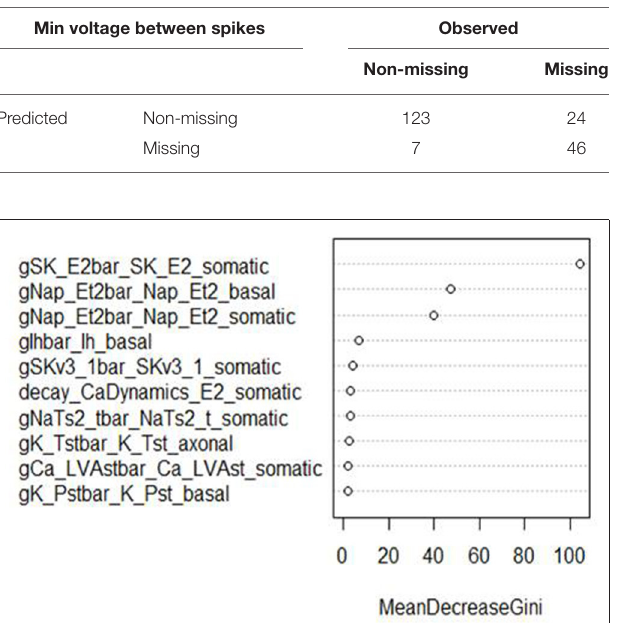
TABLE 5 | RF classifier confusion matrix for minimum voltage between spikes in generation 6.